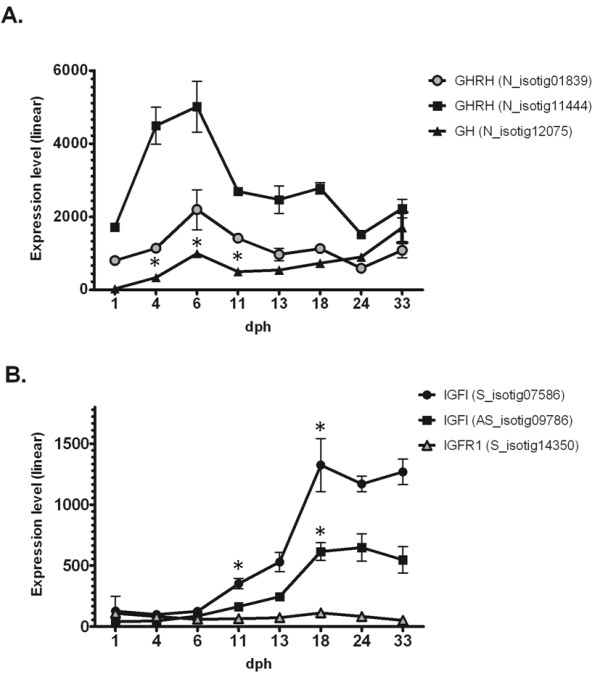
Expression of GH/IGFI axis genes during larval development. Gene expression levels (linear), from 1 to 33 dph, of S. solea transcripts codifying key genes of the GH/IGFI pathway. A.S. solea GH and GHRH transcripts; B.S. solea IGFI and IGFIR transcripts. Graphics show mean gene expression measured with microarray, bars indicate standard deviation (SD) across biological replicates. Statistical significance (p < 0.05) when comparing one larval stage against the previous one is indicated by asterisk (*).